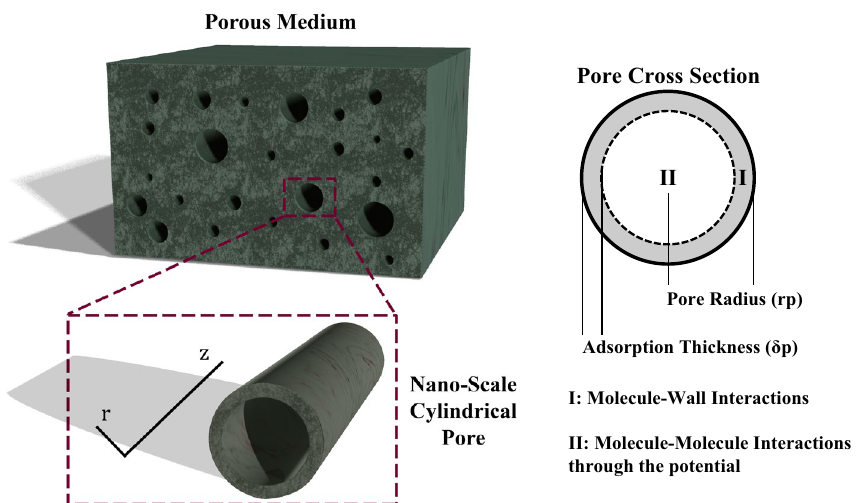
Figure 7. Schematic of a nano-scale pore in cylindrical coordinates including the adsorption thickness effect.